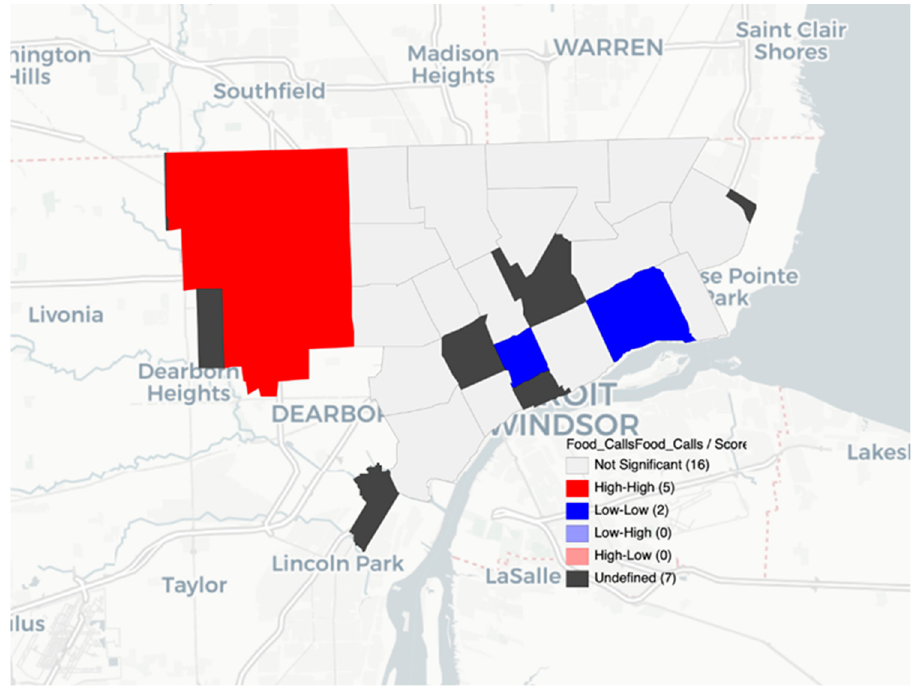
Figure 3. Food assistance calls from 211 and NEMS mean scoring by ZIP code in Detroit.